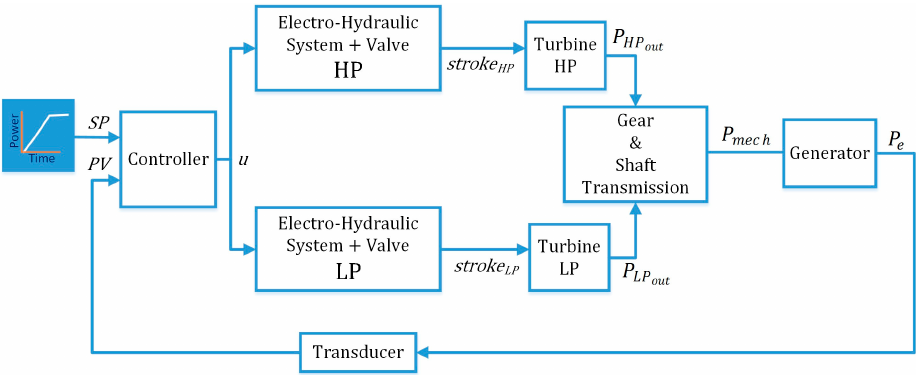
Figure 2. Block-diagram of the power control in the CSP plant.